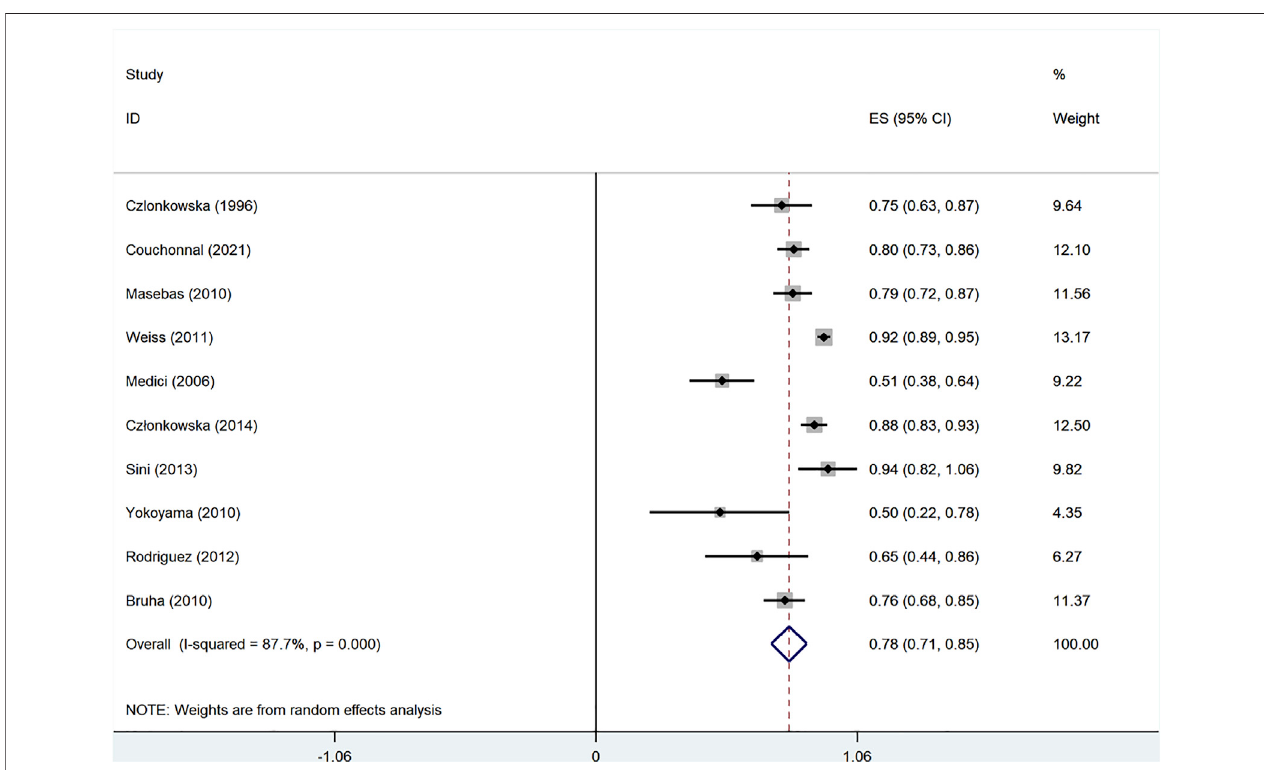
FIGURE 2 | Forest plot of the pooled improved rate for all studied Wilson disease (WD)